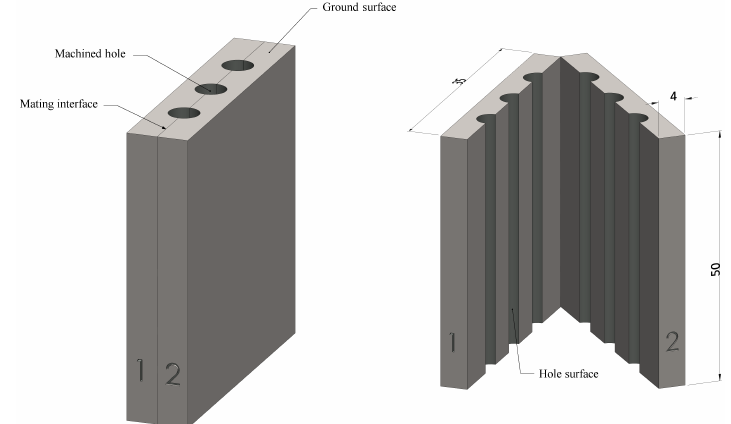
Figure 2. Sketch of specimens (all dimensions in mm).